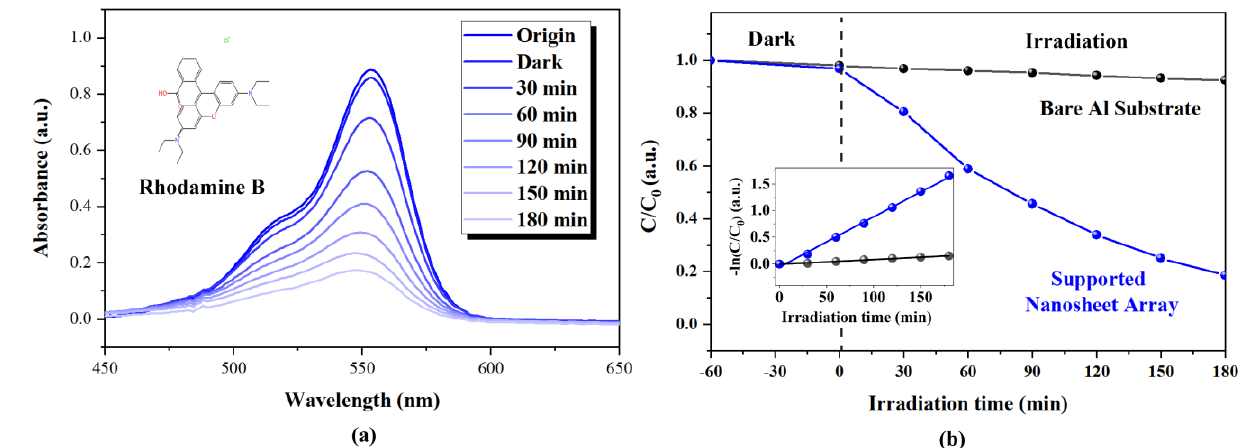
Figure 5. ( a ) Changes in UV–Vis absorption spectrum of photodegraded RhB solution with supported nanosheet arrays grown at 110 °C as a function of irradiation time ( b ) RhB concentration changes over bare Al substrate and supported nanosheet arrays as a function of irradiation time. The inset is the pseudo-first-order kinetic fitting plot of photodegradation.